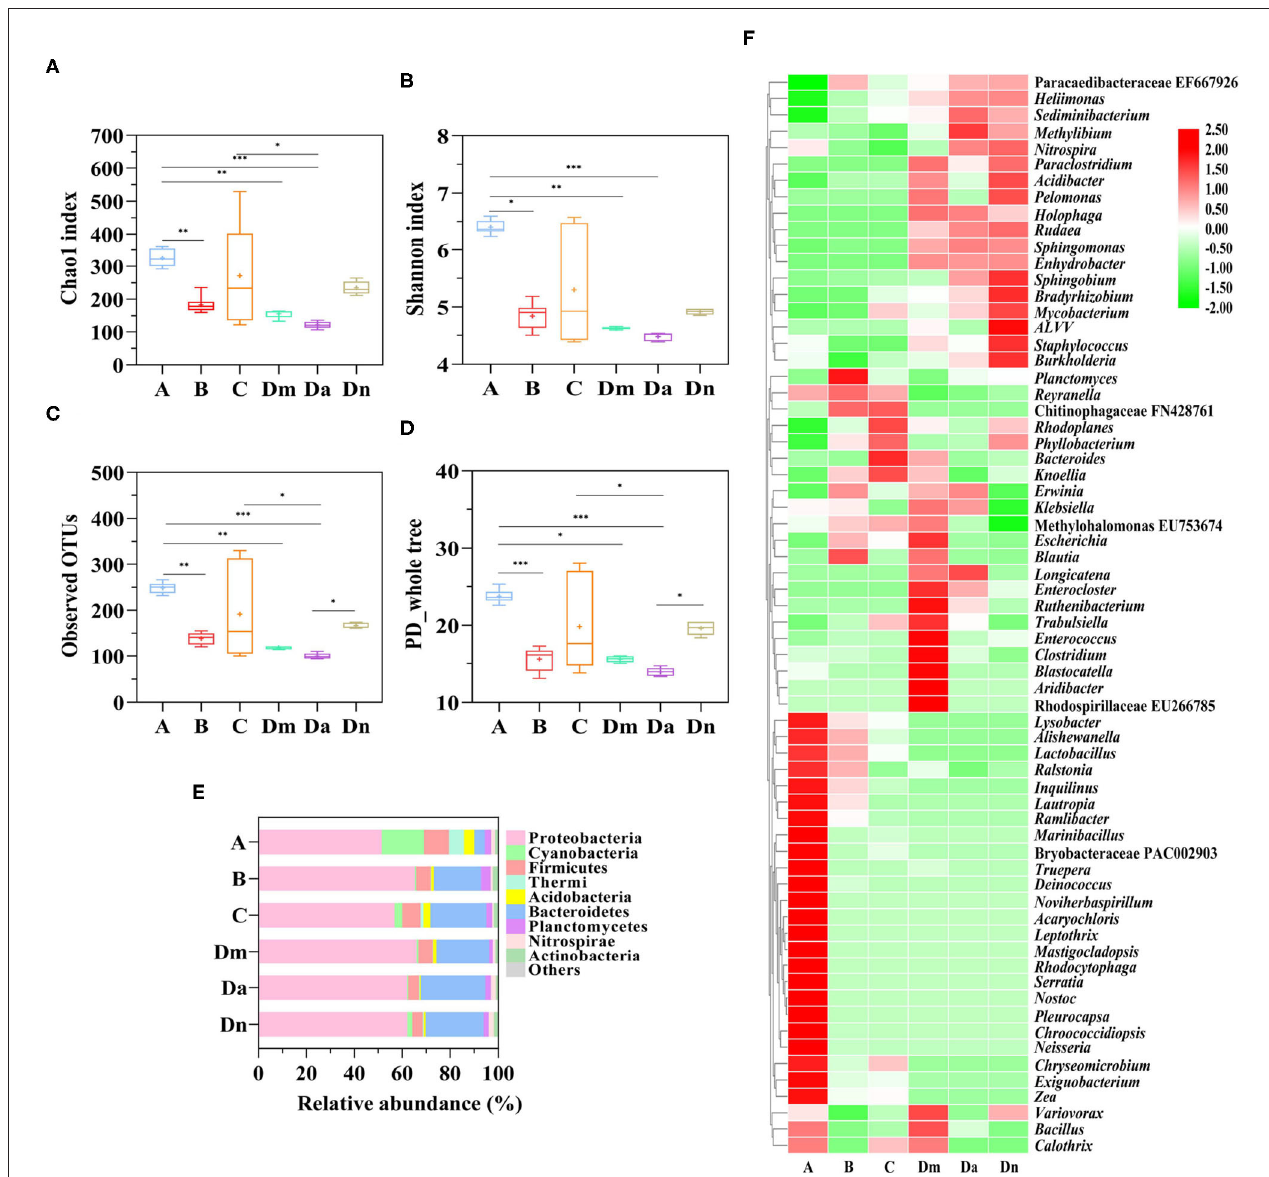
FIGURE 2 | Alpha diversity of bacterial populations from six airborne samples. Boxplots of (A) the Chao1 index, (B) the Shannon index, (C) Observed OTUs, and (D) the PD whole tree of the ambient air samples. Differences were considered significant at the P < 0.05 (*), P < 0.01 (**), and P < 0.001 (***) levels. (E) The distributions of the predominant bacteria (the 9 most abundant within each group) at the phylum level. (F) Normalized heatmap of the identified phylotypes at the genus level (The top 70 bacteria in total abundance were shown), with high and low relative abundance indicated by red and green,